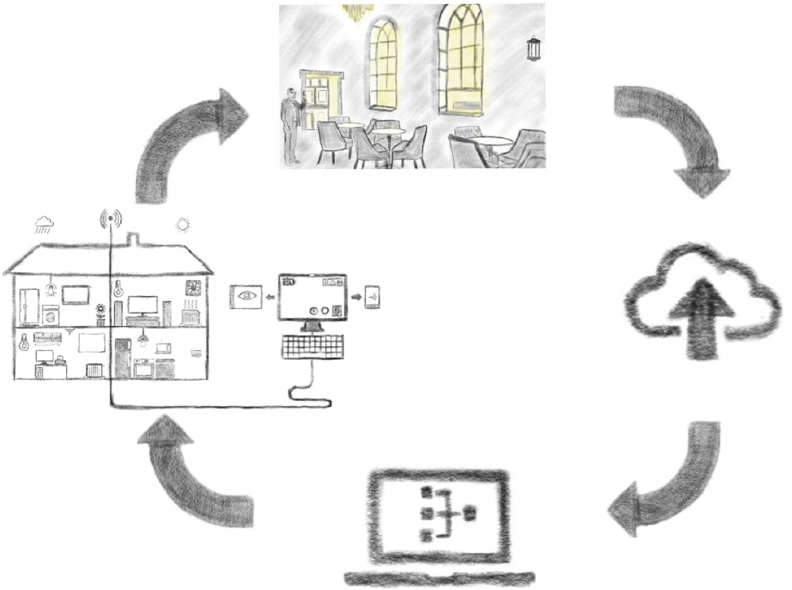
Figure 1. Adaptive building systems can collect environmental information ( top figure), store and process data ( right and bottom figures) and adjust lighting conditions to improve occupant well-being and comfort ( left figure).